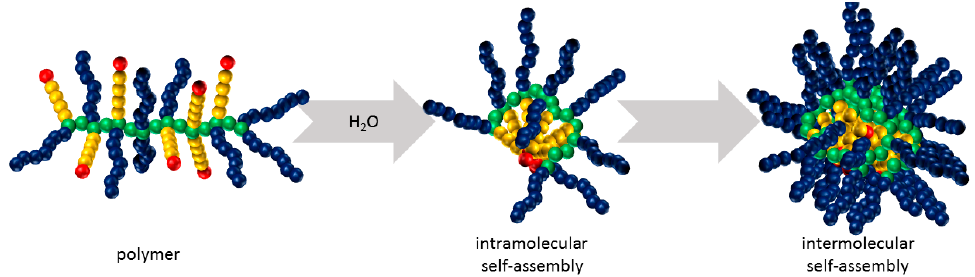
Figure 4. Intra- and intermolecular self-assembly of poly(organo)phosphazenes with amphiphilic character in aqueous solution.